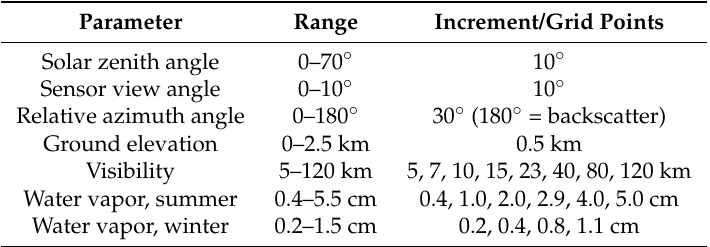
Table 1. Parameter space for atmospheric correction using Sen2Cor [32]. Some of the parameters were determined based on the image meta